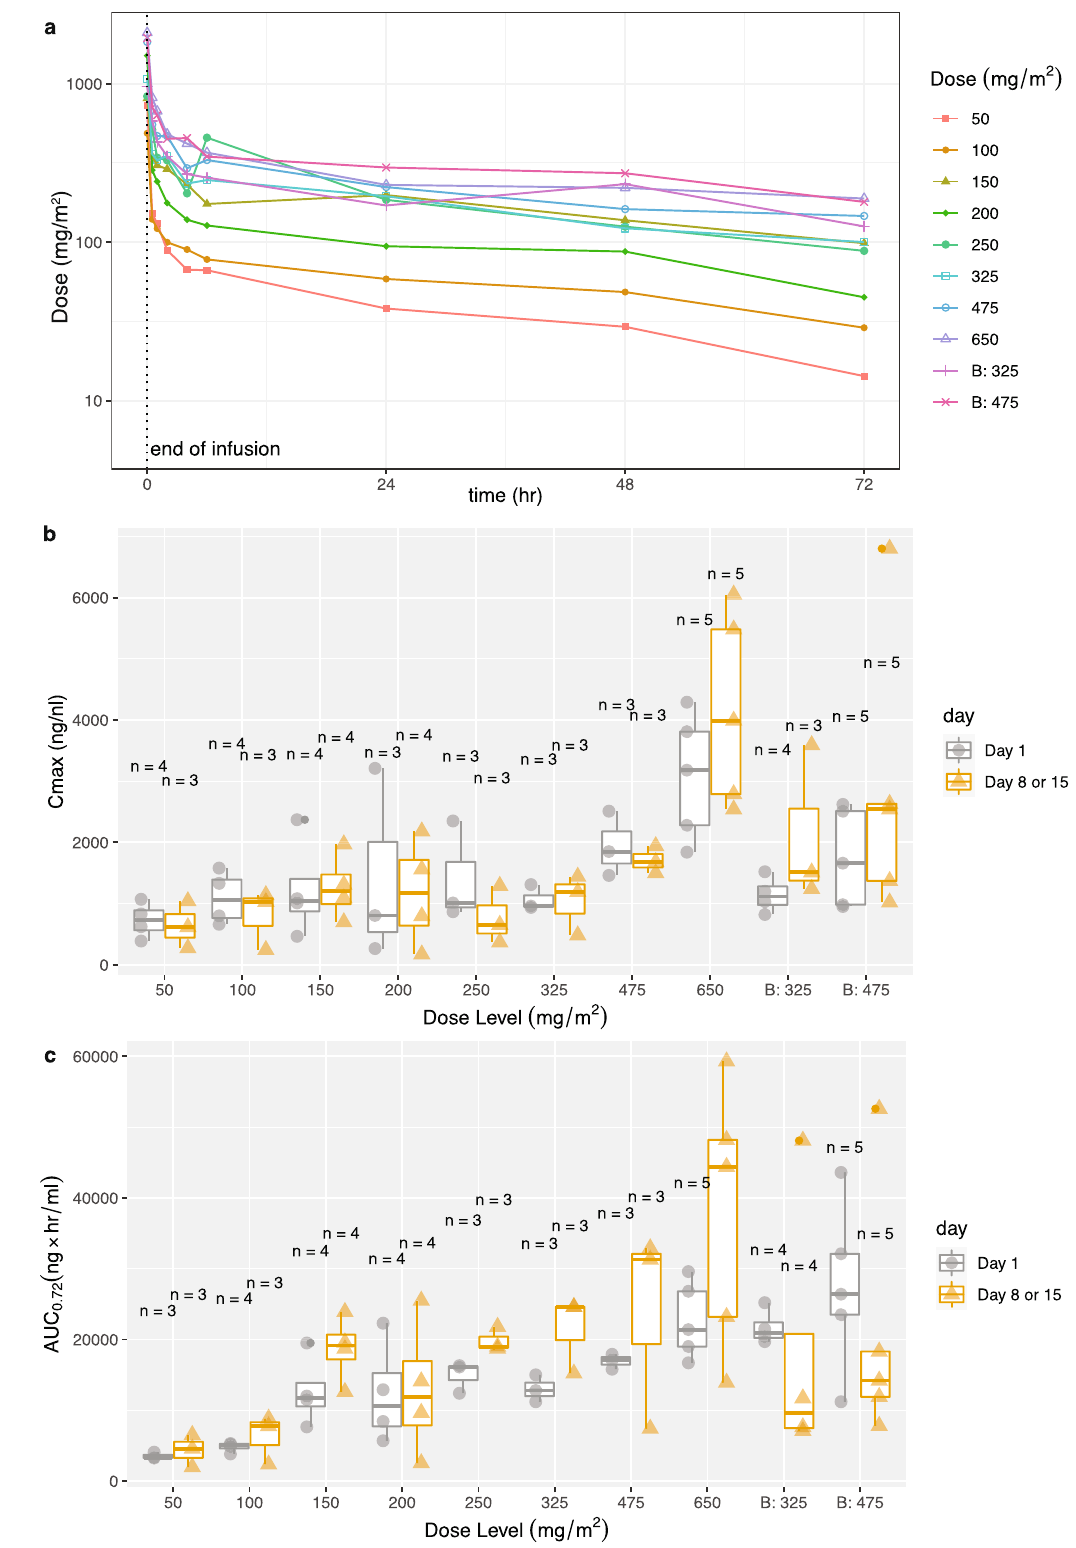
Fig. 1 Plasma pharmacokinetics of CX-5461 administration. a Day 1 CX-5461 concentration time-course from serial sampling for each dose level: 50 mg/ m 2 ( n = 3), 100 mg/m 2 ( n = 4), 150 mg/m 2 ( n = 4), 200 mg/m 2 ( n = 4), 250 mg/m 2 ( n = 3), 325 mg/m 2 ( n = 3), 475 mg/m 2 ( n = 3), 650 mg/m 2 ( n = 6), B:325 mg/m 2 ( n = 6), B:475 mg/m 2 ( n = 4). b , c C max (mean, SD), and AUC (mean, SD) for each dose level, sampled on the days shown. PK was performed on cycle 1 day 1 for all patients. Repeat samples were performed on cycle 1 day 8 for patients on a days 1, 8 schedule and on day 15 for those on a days 1, 8, 15 schedule. Repeat sample size indicated as n = above each group. Source data are provided as a Source Data fi le.